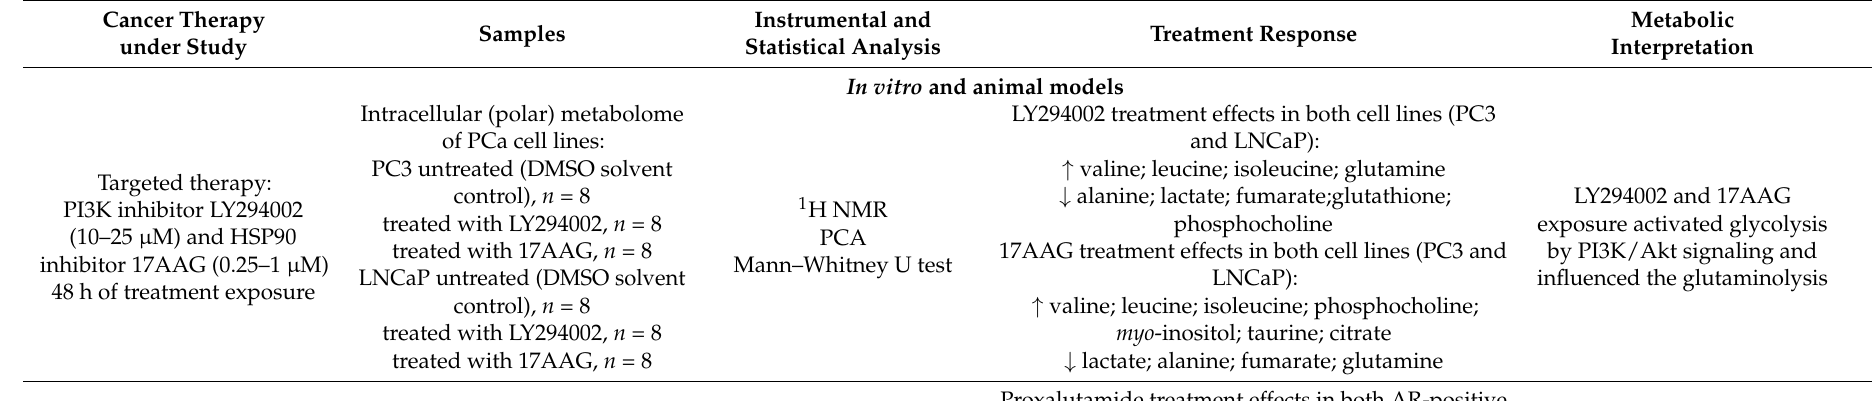
Table 1. Pharmacometabolomic studies performed in